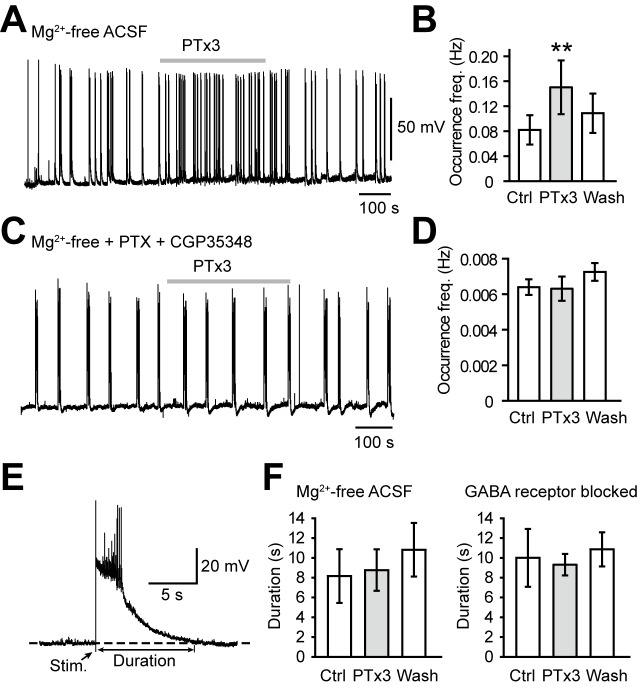
Reducing NaV1.2 currents promotes the generation of recurrent network activity.(A) Bath application of PaurTx3 (PTx3) increased the occurrence frequency of spontaneous network activity in a prefrontal cortical slice maintained in Mg2+-free ACSF (with GABA-mediated inhibition preserved). (B) Group data of Mg2+-free experiments (n = 6). (C) PTx3 showed no effect on spontaneous network activity in the presence of GABA receptor blockers (50 µM PTX and 100 µM CGP35348). (D) Group data of experiments using GABA receptor blockers (n = 7). (E) A network-activity event evoked by an electrical stimulation to the tissue showing the measurement of duration. (F) Group data showing that PTx3 had no effect on the duration of the network activity evoked in either conditions. For (B), (D), and (F), paired t test, ** p<0.01. Error bars represent s.e.m.